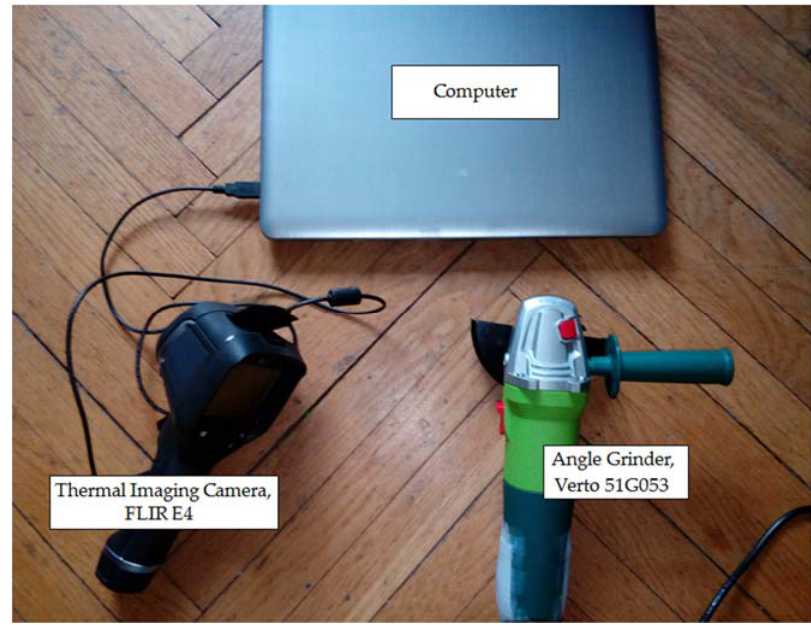
Figure 1. Measurement of the thermal image of the angle grinder (Verto 51G053). Acquisition of thermal images is the first step of recognition of the state of the angle grinder. Measurement distance is equal to 0.4 m. The emissivity coefficient of the analyzed thermal image is equal to 0.6. The emissivity coefficient of steel elements should be 0.52–0.85. The emissivity coefficient of cold-plated steel (93 ◦ C) is in the range of 0.75–0.85. The emissivity coefficient of steel surface hardened (200 ◦ C) is equal to 0.52. The emissivity coefficient of stainless steel type 301 is in the range of 0.54–0.63. Slight shifts of thermal imaging camera(+/ − 0.1 m) do not cause major changes for recognition results. Next, the captured movie is converted into thermal images. Thermal images are processed by the BCAoMID − F. Features of images are computed. Next, features are classified by the nearest neighbor classifier and Support Vector Machine. Processing and recognition of thermal images of the inspected angle grinder are shown in Figure 2. Matlab is used for the recognition and processing of thermal images.